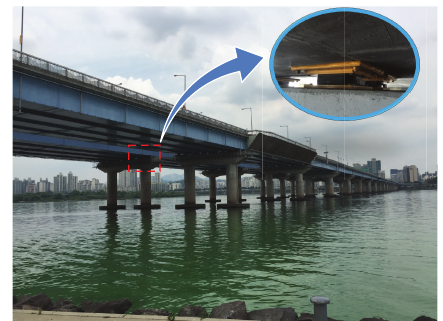
Figure 1: Bridge bearing installed under the steel box girder.